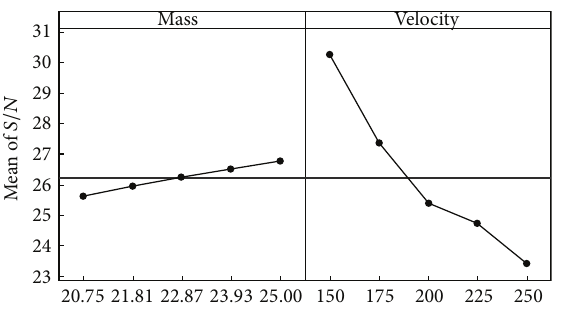
Figure 10: Main effects of